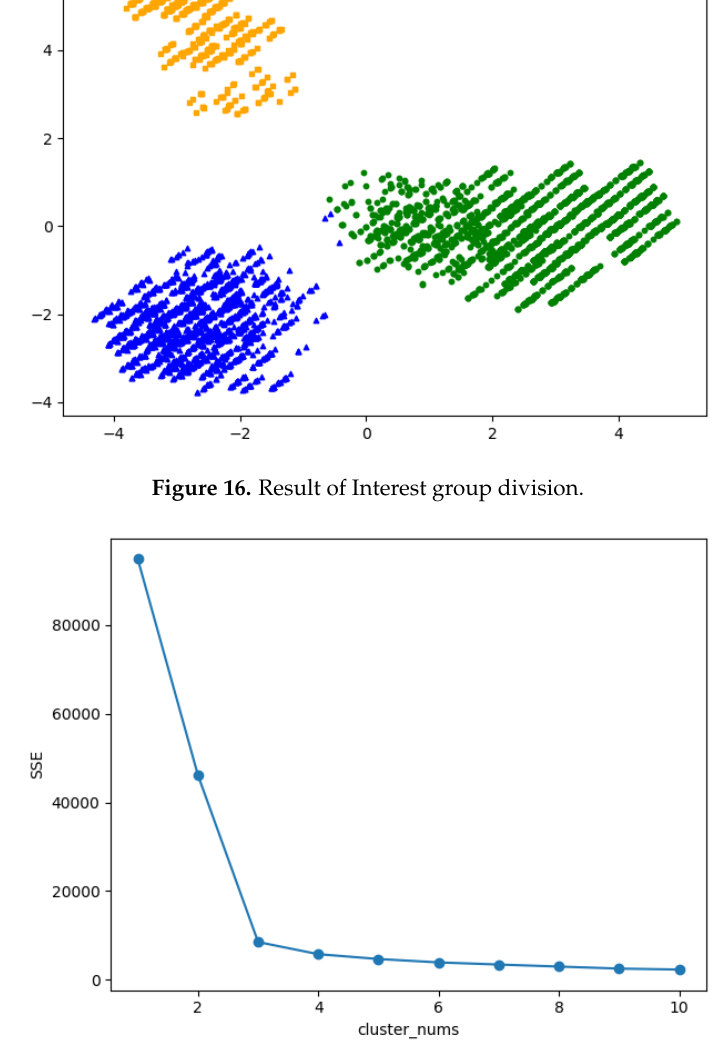
Figure 17. SSE at different K